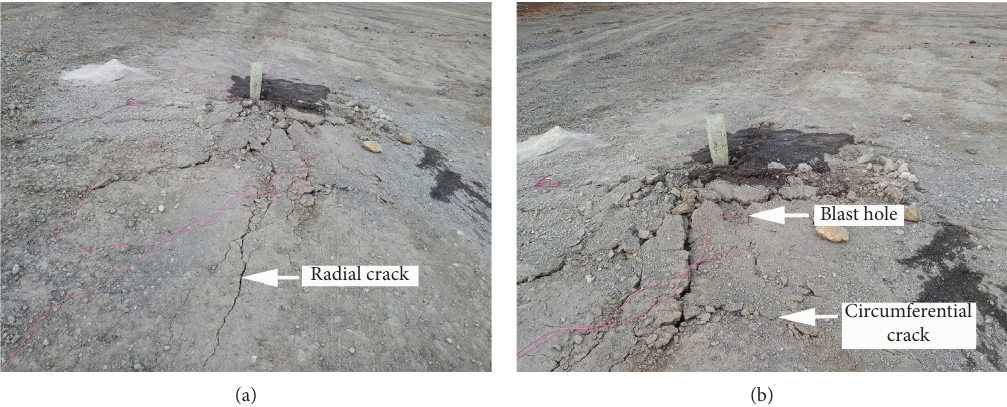
Figure 8: Fracture diagram after the blasting test: (a) radial crack; (b) circumferential